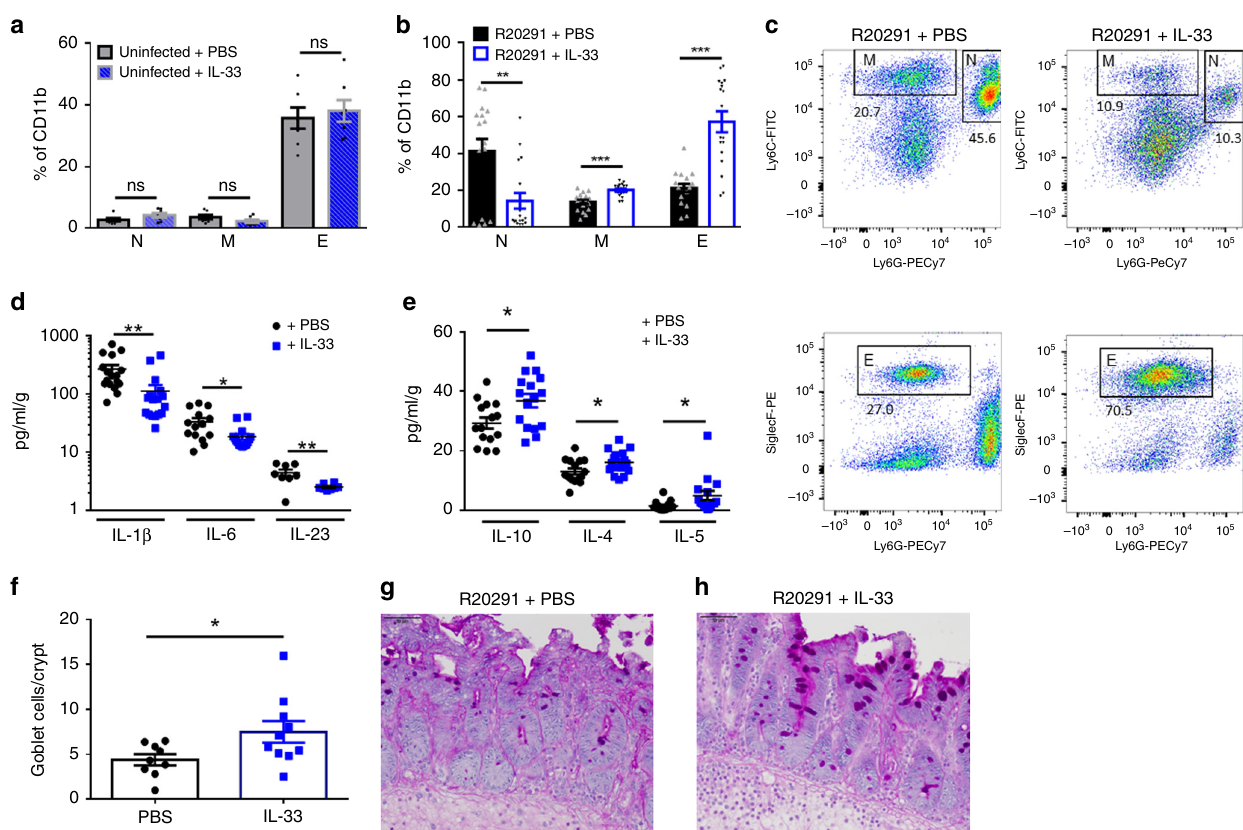
Fig. 3 IL-33 dampens in fl ammation and skews gut type-2 immunity during CDI. a – c Immune pro fi ling of myeloid cells within the colon of IL-33-treated or untreated mice. a , b Quanti fi cation of the frequency of N = neutrophils (CD45 + CD11b + Ly6g + Ly6c + ), M = monocytes (CD45 + CD11b + Ly6g - Ly6c + ), and E = eosinophils (CD45 + CD11b + SiglecF + Ly6g − ) in the colon of ( a ) antibiotic-treated mice or ( b ) R20291-infected mice. c Representative dot plots of myeloid cells within the colon of IL-33-treated (right plots) vs. untreated (left plots) mice. d , e Cytokine protein expression in cecal tissue during C. dif fi cile infection. d Proin fl ammatory IL-1 β , IL-6, and IL-23 expression and ( e ) anti-in fl ammatory IL-10, IL-4, and IL-5 expression with and without IL-33 treatment. f – h Enumeration of mucin + goblet cells with and without IL-33 treatment by microscopy. f Blinded quanti fi cation of number of PAS + goblet cells per colon crypt during R20291 infection (day 2). g , h Representative PAS + goblet cell staining of the ( g ) vehicle or ( h ) IL-33 treated mice. a – e Comparison made by two-tailed student t test as described in methods ( a , n = 7; b , n = 17,18, d , n = 17,16,8; e , n = 15,16; f , n = 9,10). The data representative of three Scale bar is 50 μ m. Error bar indicates